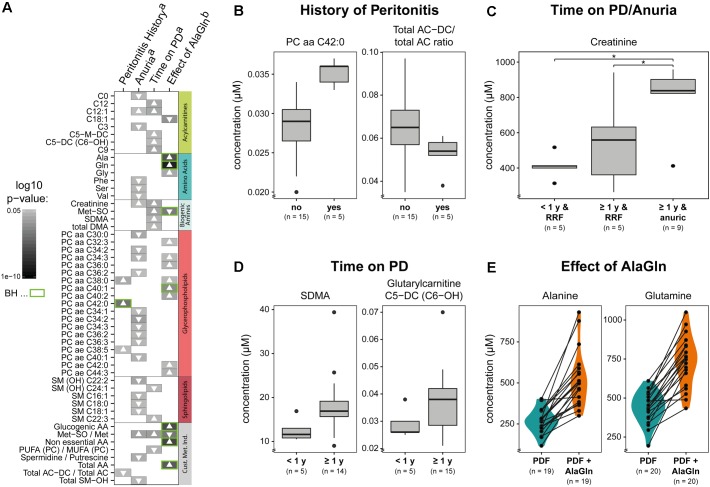
Effects on PD effluent small molecule profiles of patient factors, therapy characteristics, and PD fluid supplementation with alanyl-glutamine (AlaGln). Data shown are from PD effluents obtained after a standardized 4 h peritoneal equilibration test (PET) dwell. (A) Effects of (B) peritonitis history, (C) anuria, (D) chronic PD duration (< or ≥1 year), and (E) effect of 8 mM AlaGln supplementation of PD fluid (vs. standard PD fluid in one 4 h PET). All metabolites with significant results in at least one comparison are shown panel (A) with selected comparisons presented in detail panels (B–E). Results from all t-tests are reported as gray-scale tiles with darker colors representing higher significance (highest p-value 0.049), with Benjamini-Hochberg-corrected p-values (green: BH < 0.05) (C) Kruskal-Wallis: χ2 = 6.93, p = 0.049; Dunn’s post hoc test between groups: <1 year and RRF vs. ≥1 year and RRF p = 0.1506; ≥1 year and RRF vs. ≥1 year and anuric p = 0.0440 (∗); <1 year and RRF vs. ≥1 year and anuric p = 0.0078 (∗); a, Welch t-tests; b, paired t-tests, to investigate the effect of AlaGln supplementation in the cross-over study. Met-SO, methionine sulfoxide; SDMA, symmetric dimethylarginine; total DMA, symmetric and asymmetric dimethylarginine; PUFA (PC)/MUFA (PC), ratio of polyunsaturated to mono-unsaturated glycerophospholipids; AC-DC, dicarboxy acylcarnitines; AA, amino acids; RRF, residual renal function.